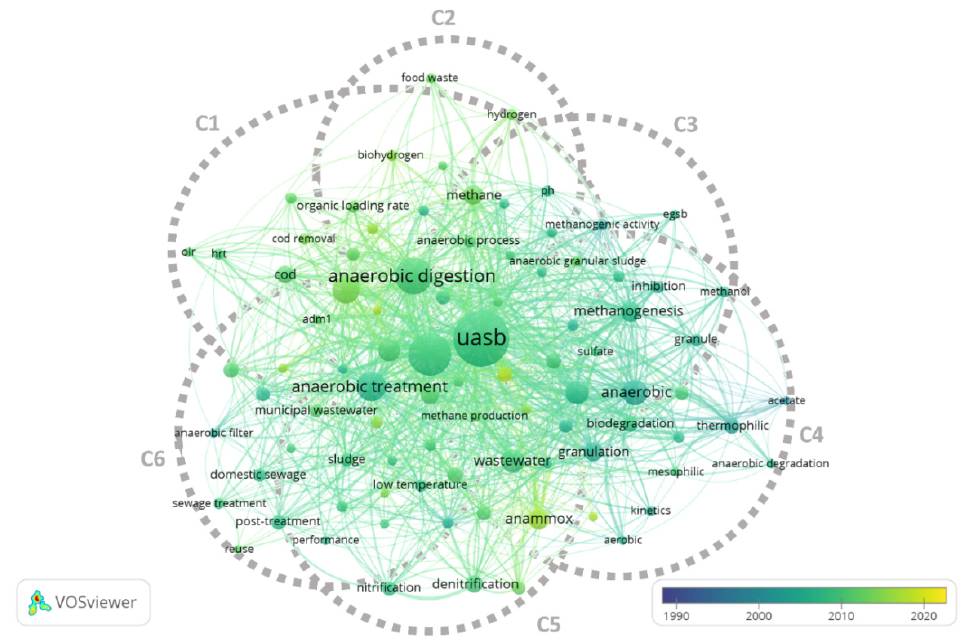
Figure 3. Overlay visualization of co-occurrences by author keywords of records in G1. Diverse colours represent diverse years of publication. Cluster analysis and graphic representation were made using VOSviewer software. C: cluster.